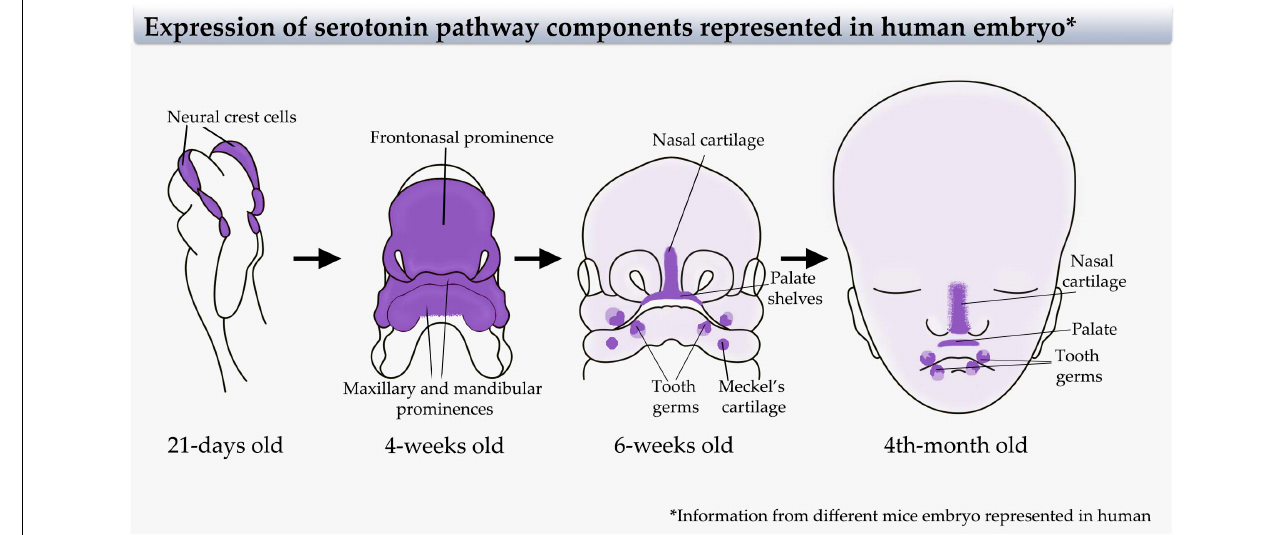
FIGURE 2 | Serotonin pathway component expression in the craniofacial region represented in the human embryo. Sites of serotonin signaling components expression [receptors and serotonin transporter (SERT)] extrapolated from mice embryo animal model (Moiseiwitsch and Lauder, 1995, 1996; Moiseiwitsch et al., 1998; Lauder et al., 2000) to a human embryo. Left-to-right: A 21-day-old human embryo (representing the information from E9.5 mice embryo) showing expression in neural crest cells. A 4-week-old human embryo (representing the information from E11.5 mice embryo) showing expression in the first pharyngeal arch and frontonasal prominence. A 6-week-old human embryo (representing the information from E13.5 mice embryo) showing specific expression in the tooth germ, palate, first arch cartilage, and nasal cartilage, and a wide light color representing the expression in the developing craniofacial skeleton. A 4-month-old human embryo (representing the information from E16.5 mice embryo) showing expression in tooth germ, palate, nasal cartilage, and wide light expression in the craniofacial skeleton. Modified from Adameyko and Fried (2016).